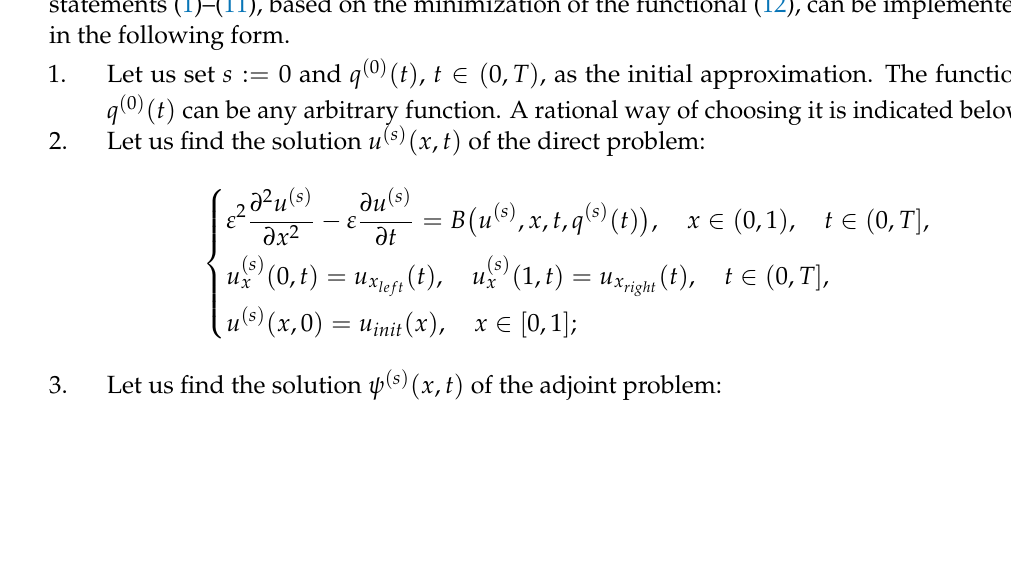
( t ) , determined in the experiment, in comparison with Figure 7. Typical form of the function f 2 δ 2 f 2 ( t ) . The figure shows the simulation result for a set of model parameters (10), ε = 10 − 1 , with errors = 0% and “ δ (cid:48)(cid:48) = 75%). δ 1 = 0 and δ 2 ∼ 7.15 × 10 − 2 (matches “ δ (cid:48)(cid:48) 2 1 The algorithm for the numerical solution of the inverse problem in the